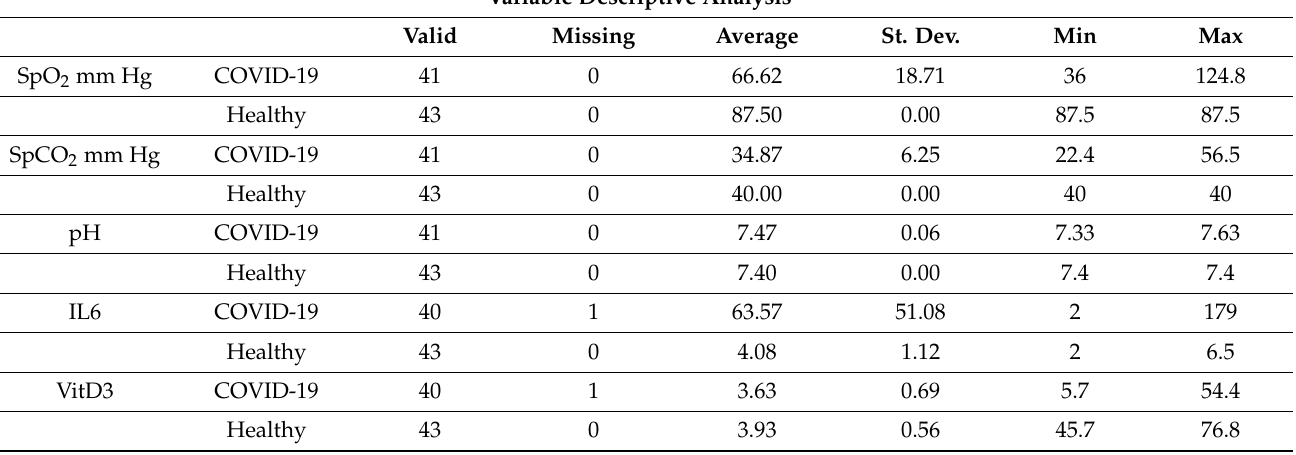
Table 3. Descriptive analysis of the variables under examination, divided by COVID-19 and healthy groups.